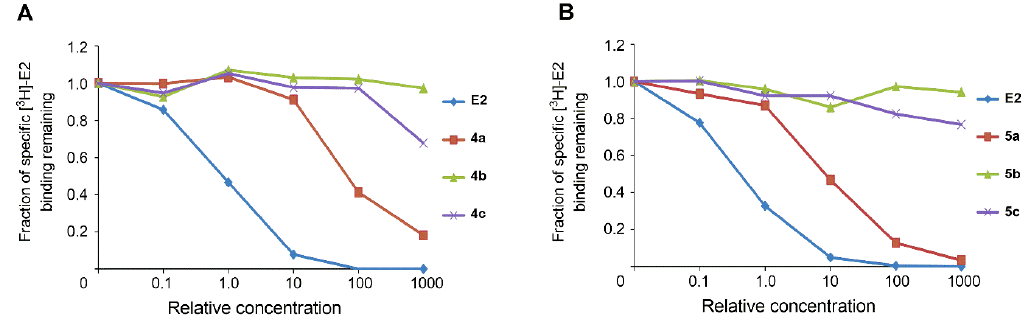
Figure 2. Dose-response curves obtained from a competitive binding assay of compounds 4a – 4c ( A ) and 5a – 5c ( B ) toward ER α . All binding assays were performed in duplicate ( n = 2). IC 50 value of E2 for ERa is 4 nM. Table 1. Biological profiles of compounds 4a ‒ 4d and 5a ‒ 5d.